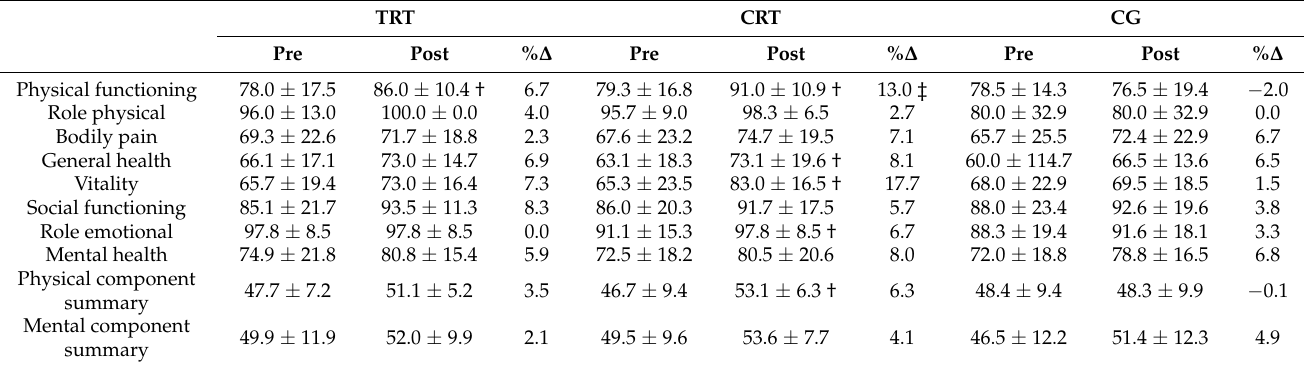
Table 2. Pre- and post-training values of perception of HRQoL. Values are given as mean ±